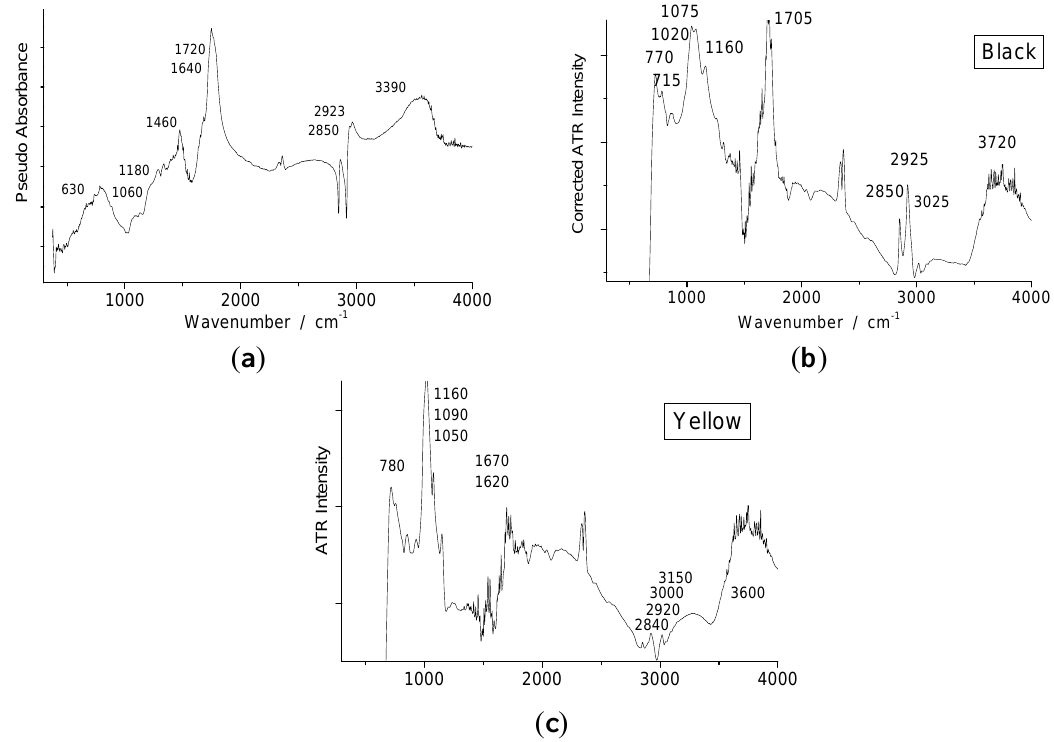
Figure 4. Pseudo-absorbance spectrum ( a ) recorded with portable IR instrument on the black Japanese tray (Figure 1a) and ( b ) ATR-FTIR spectrum recorded using the ATR accessory on a black small scale sampled on the tray back rim; ( c ) ATR corrected FT-IR spectrum recorded using the mobile ATR accessory on a small yellow scale sampled from the tray